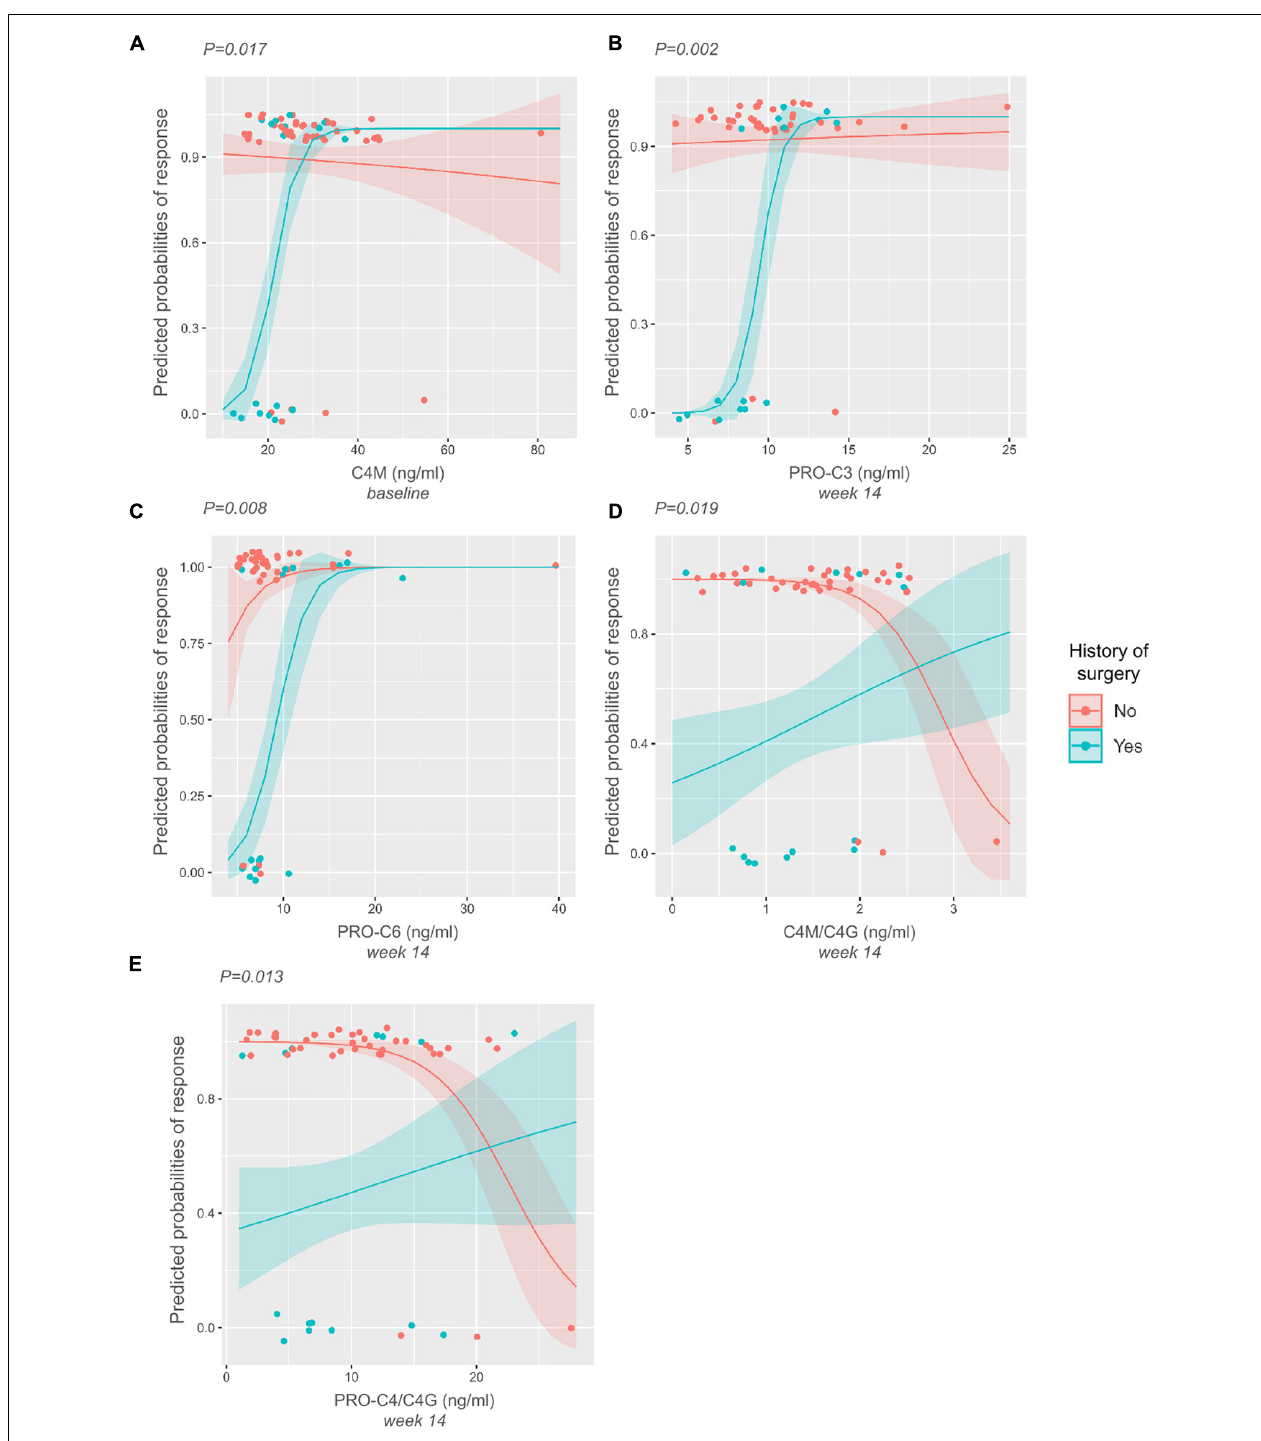
FIGURE 4 | Interaction plots displaying differing biomarker behavior depending on the history-of-surgery status. P -values are derived from likelihood-ratio tests depicting the significance of the interaction between the biomarkers and history of prior surgery. (A–C) Low baseline levels of C4M, and low levels of PRO-C3 and PRO-C6 at week 14 are indicative of non-response to treatment in patients with surgical history. (D–E) Low levels of C4M/C4G and PRO-C4/C4G at week 14 are indicative of response to treatment in patients without surgical history. The opposite can be seen within the group of patients with surgical history, where low levels of these ratios decrease the probability of responding to